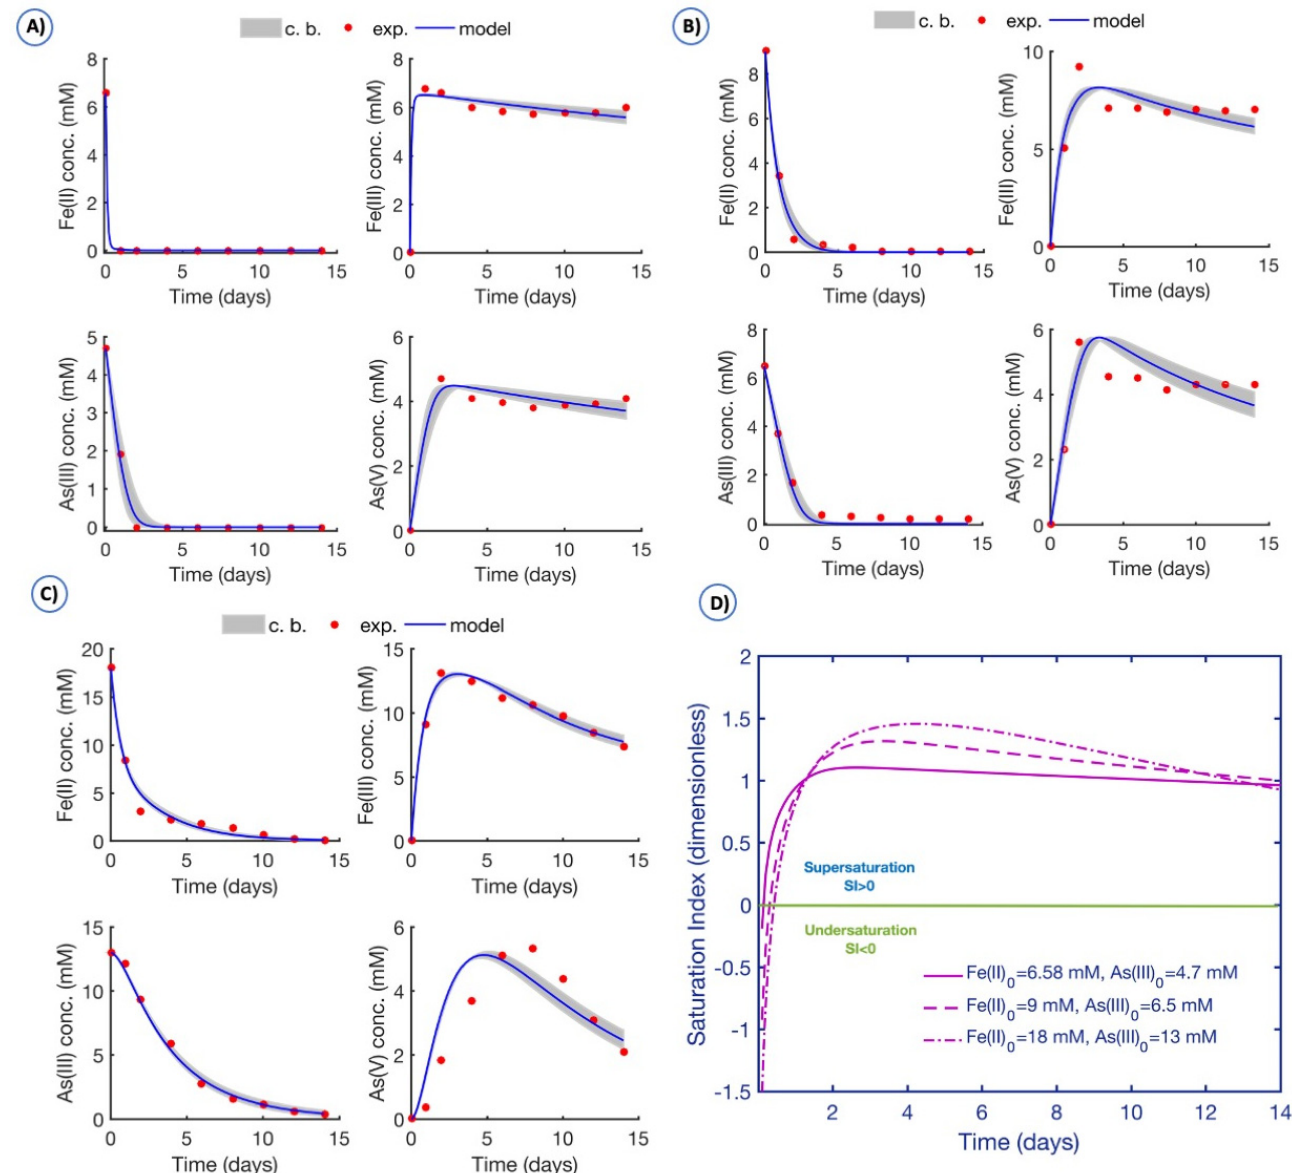
Figure 3. Model evaluation and confidence bands for different data sets performed on Fe(II)/As(III) = 1.4: ( A ) S-1, experiment with Fe(II) 0 = 6.58 mM and As(III) 0 = 4.7 mM; ( B ) S-2, experiment, with Fe(II) 0 = 9 mM and As(III)0 = 6.5 mM; ( C ) S-3, experiment with Fe(II) 0 = 18 mM and As(III) 0 = 13 mM.